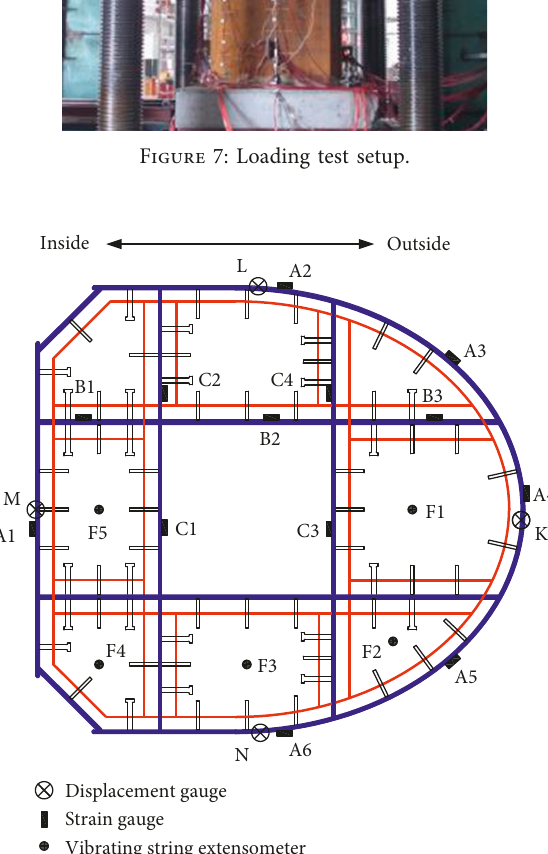
Figure 8: Layout of measuring positions.